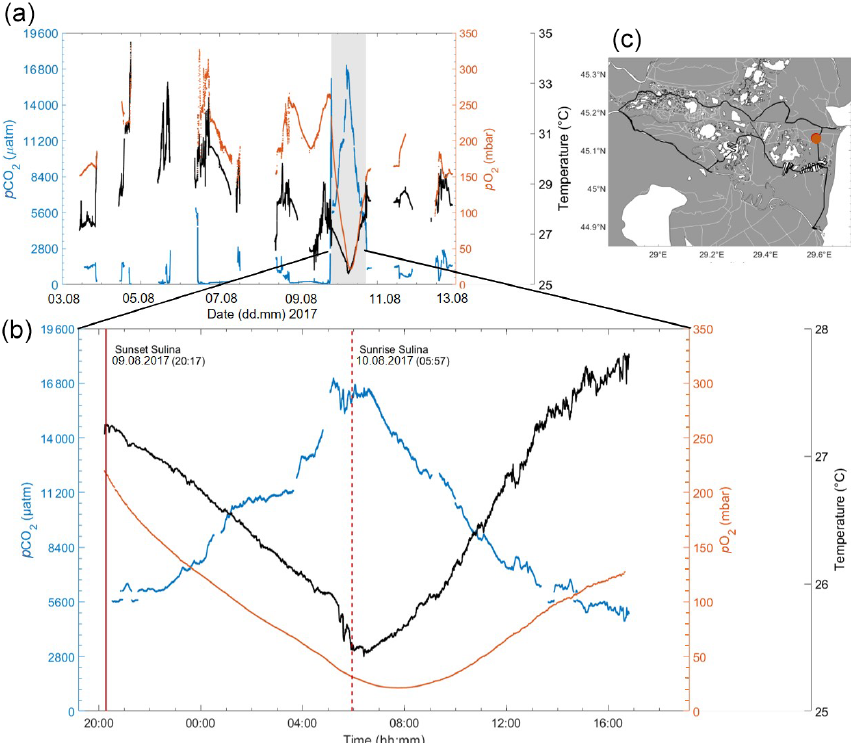
Figure 12. (a) Measurements of p CO 2 (in µatm; blue), p O 2 (in mbar; orange) and temperature (in ◦ C; black), during the Danube river campaign, Rom2, in summer 2017. The grey rectangle highlights a 24h cycle acquired at a fixed location in a channel. (b) Close up of this 24h cycle, with sunset (solid red) and sunrise (dashed line red) indicated, showing extreme variability in the diel cycle timescale. (c) Cruise track of the campaign, with the red dot indicating the position of the 24h stationary data